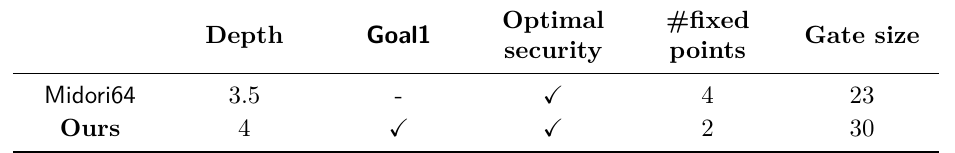
Table 7: Comparison of involution